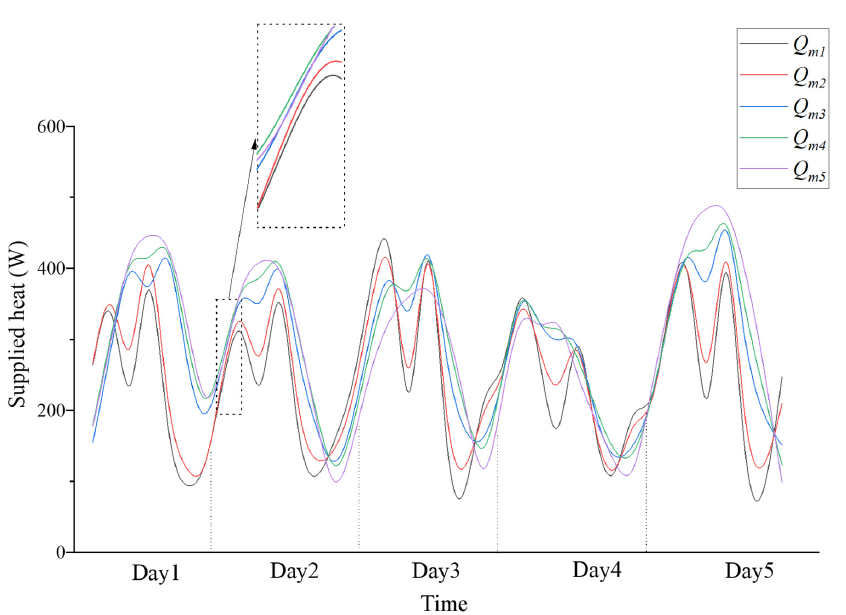
Figure 17. Supplied heat at each measuring point.